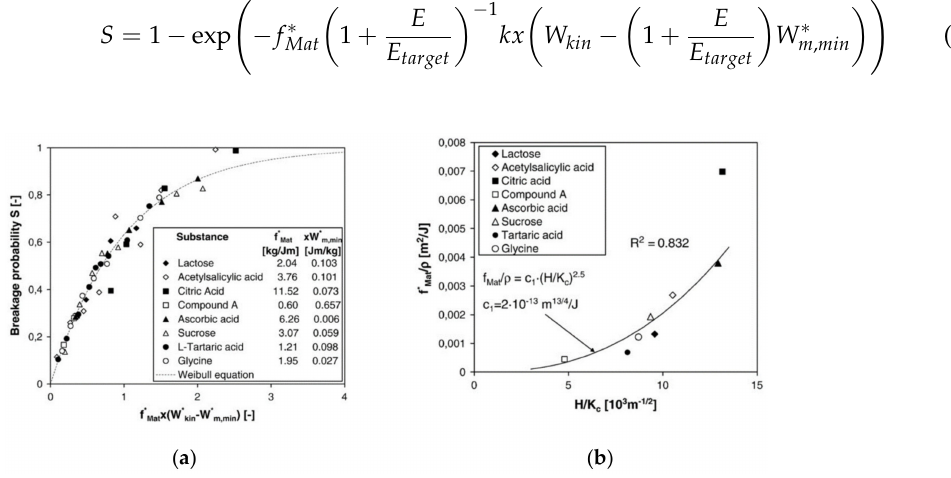
Figure 13. ( a ) Master curve for the breakage probability S by impaction (reprinted with permission from [72], Elsevier, 2009). ( b ) Material parameter f ∗ mat divided by the particle density as function of hardness H and fracture toughness K c (reprinted with permission from [72], Elsevier,